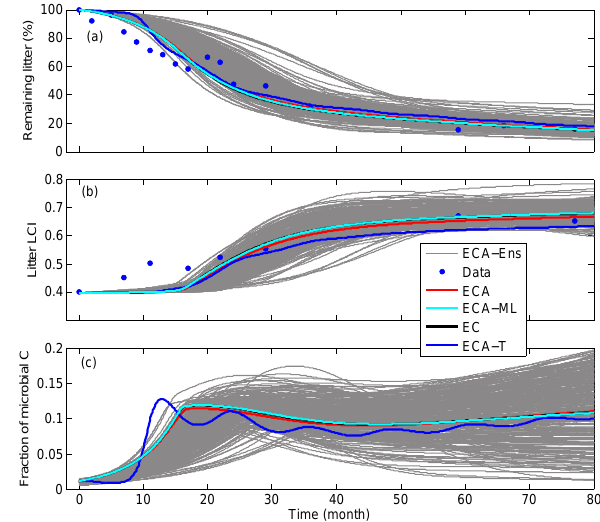
Fig. 11. Posterior simulations from calibrating model S3B3-ECA to the red pine litter decomposition experimental data in Melillo et al. (1989). ECA-Ens indicates the posterior ensemble simulations, and ECA-T indicates the additional temperature impact on top of ECA (i.e., the best fitting posterior simulation). The best-fit kinetic parameters for ECA, EC, ECA-ML, and ECA-T are in Table 5. See text for further